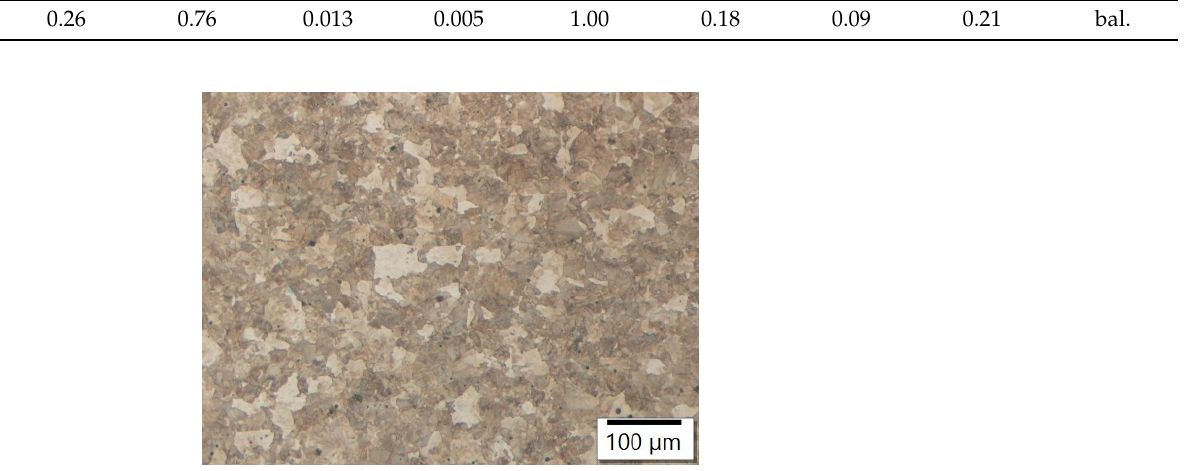
Figure 1. Ferritic–pearlitic microstructure of as received 51CrV4 steel sample, etched with Nital at 100× magnification.